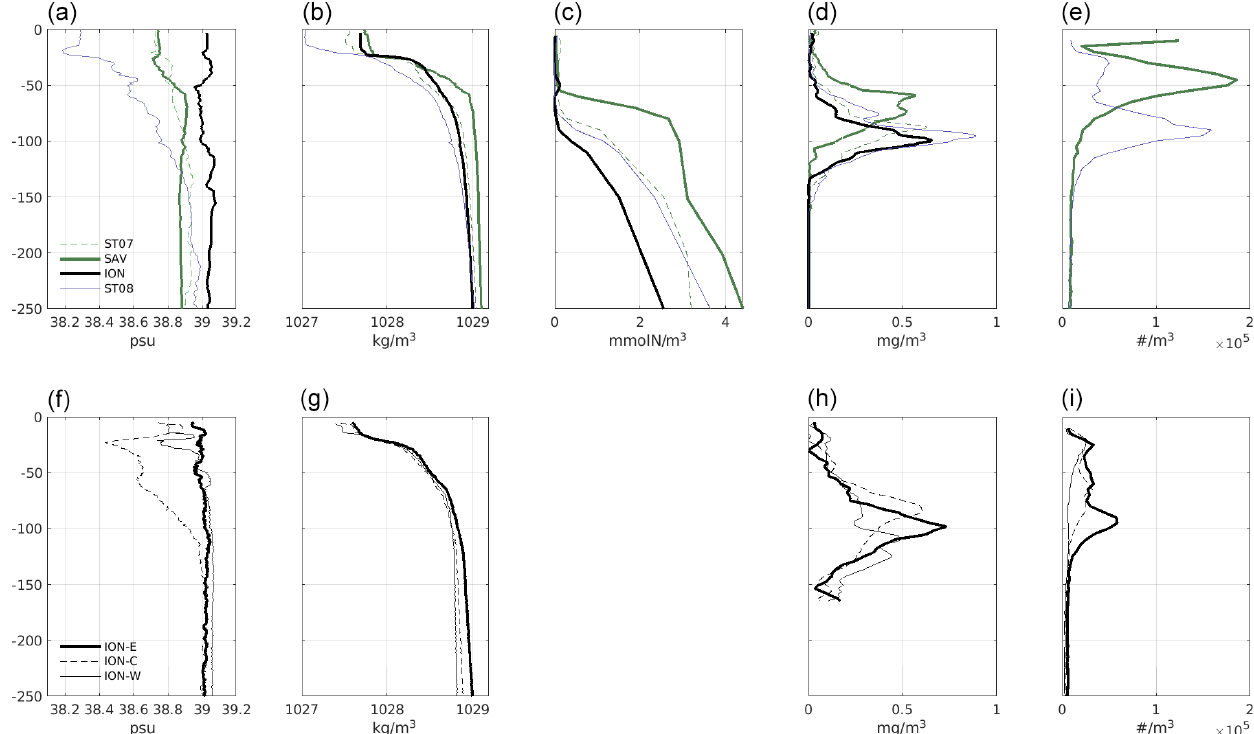
Figure 7. Vertical profiles of variables at ION, SAV, ST7 and ST8 (a–e) and for ION-W, ION-C and ION-E (f–i) . (a, f) Salinity, (b, g) density, (c) nitrate, (d, h) chl a and (e, i) total particle abundance. Note that particles were not quantified at ST7. For chl a and particles, an average over three profiles was